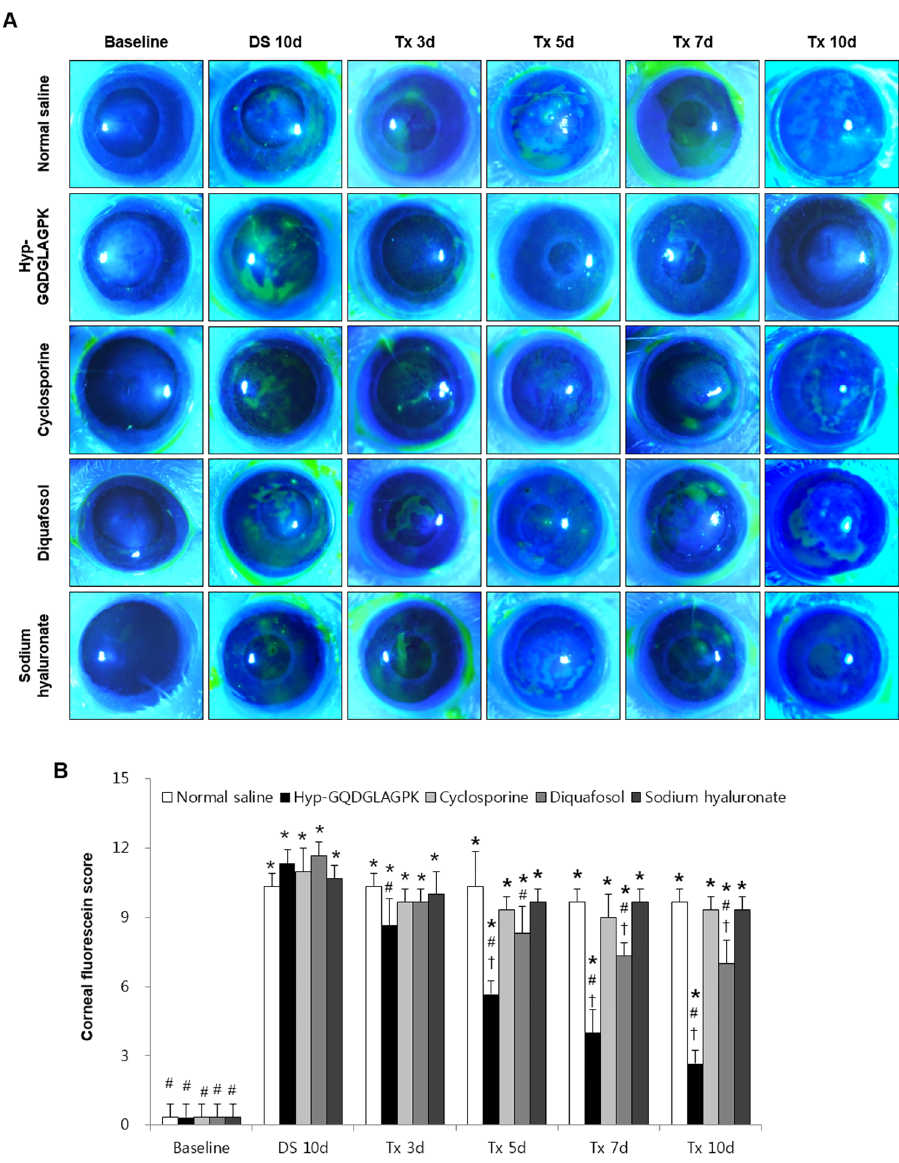
Figure 3. Effect of Hyp-GQDGLAGPK on corneal fluorescein staining. ( A ) Fluorescent slit-lamp photographs of the eyes of the Hyp-GQDGLAGPK, cyclosporine, diquafosol, and sodium hyaluronate groups were photographed with a microscope at baseline; after DS 10d; and after treatment for 3, 5, 7, and 10 days. ( B ) Corneal fluorescein grading score at each time point. The quantitative data are presented as means ± SD (n = 13). The results are statistically significant by analysis of variance with the Tukey test at * p < 0.05 compared with baseline, # p < 0.05 compared with DS 10d and † p < 0.05 vs corresponding value in the normal saline group. Baseline = before desiccation stress; DS 10d = immediately after desiccation stress for 10 days; Tx 3d, Tx 5d, Tx 7d, and Tx 10d = 3, 5, 7 and 10 days after treatment with Hyp-GQDGLAGPK, cyclosporine, diquafosol, and sodium hyaluronate eye drops,